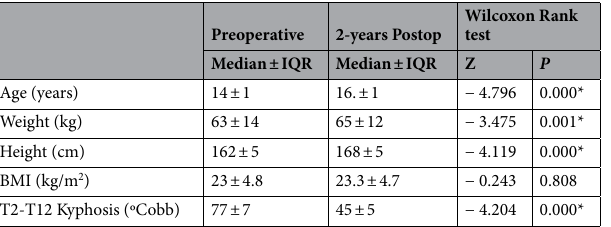
Table 1. Anthropometric, and thoracic kyphotic curve characteristics of the SK patients before and after surgery. IQR: Interquartile range; * P <